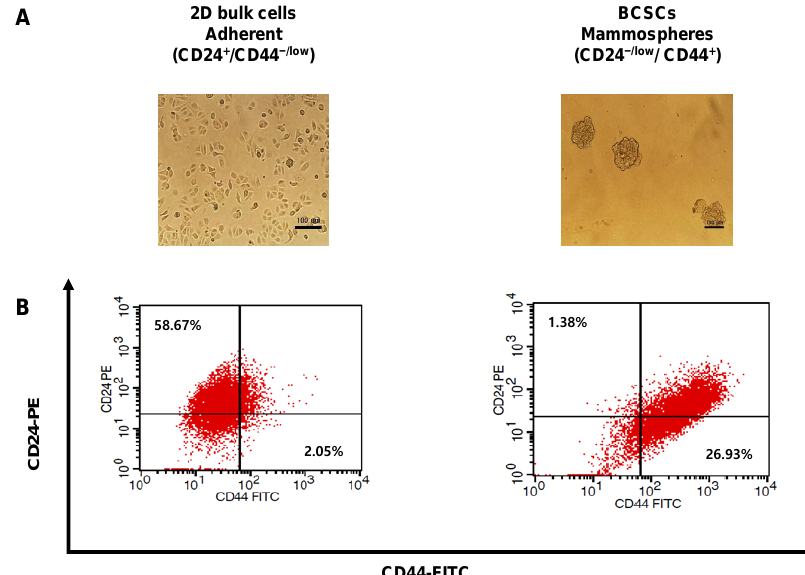
Figure 1 Figure 1. ( A ) Images of 2D bulk cells and breast cancer stem cells (BCSCs) under a light microscope (scale bar: 100 µ m). ( B ) Phenotype characterization of 2D bulk cells and BCSCs via flow cytometry using anti-CD44-FITC and anti-CD24-PE staining.